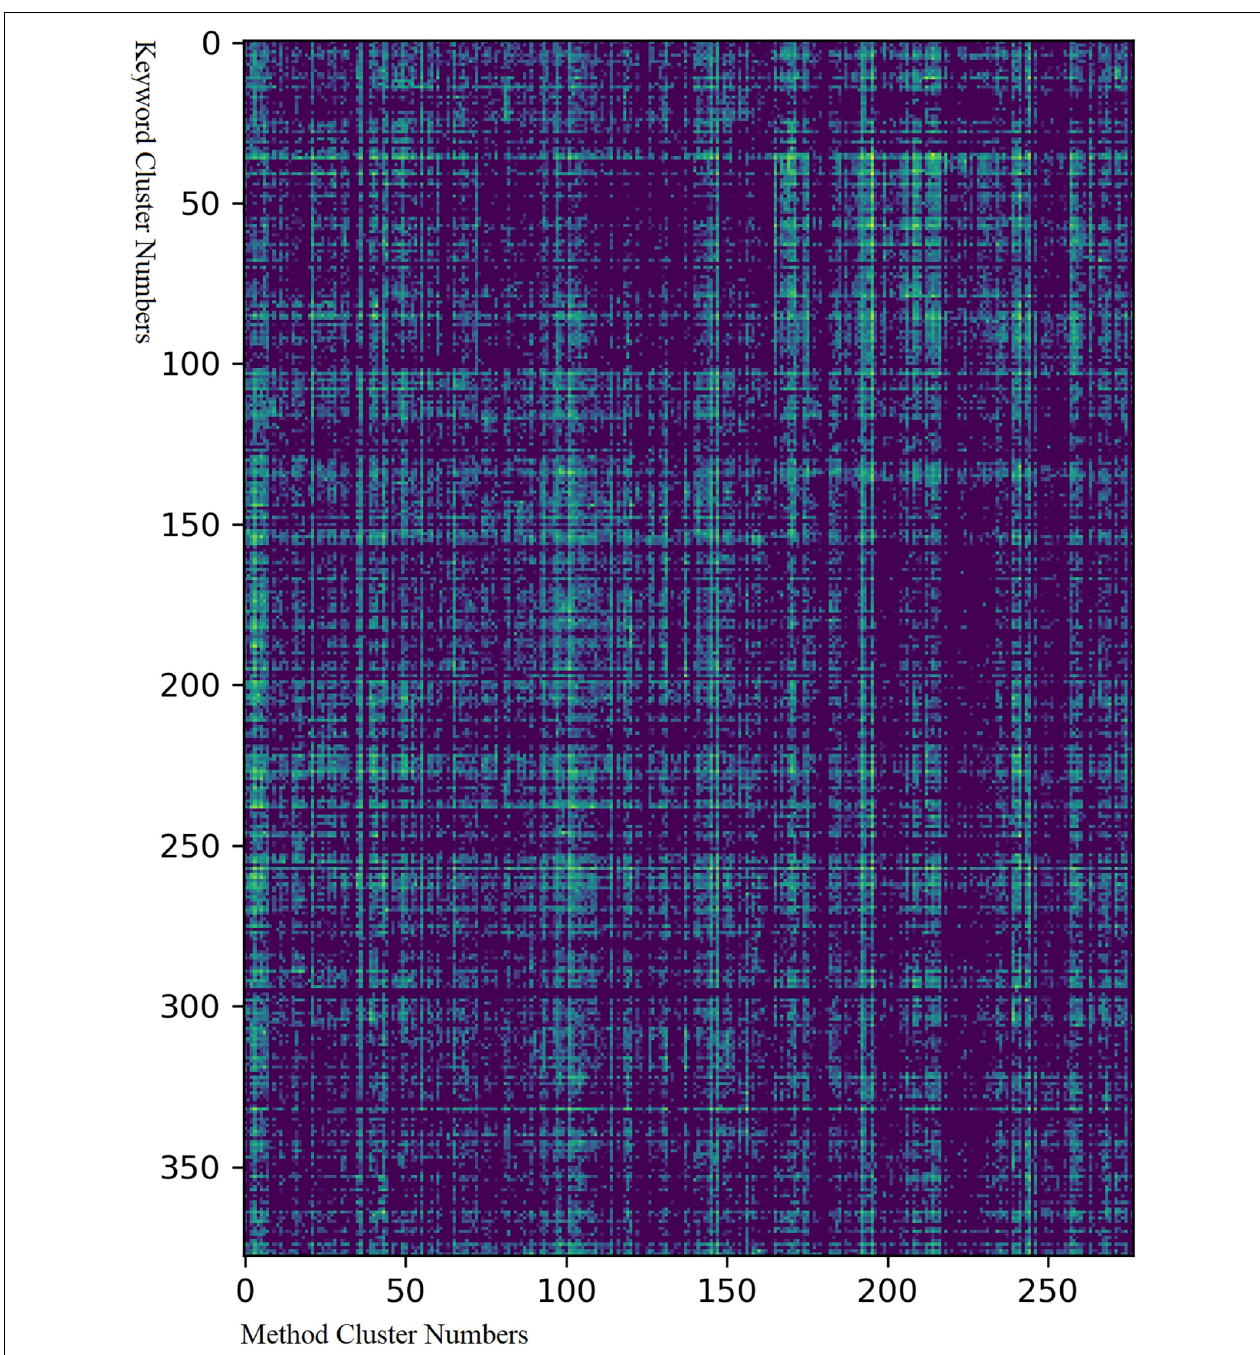
FIGURE 6 | Matrix of combinations between clusters of keywords and methods. The Y-axis represents the number of keyword clusters from 1 to 378 while the X-axis the number of method clusters from 1 to 277. The corresponding data are provided in Supplementary Material S7 . The colors represent how often a method and a keyword cluster appeared together and were cited in one article: yellow means that this happened very often while deep blue means that it never